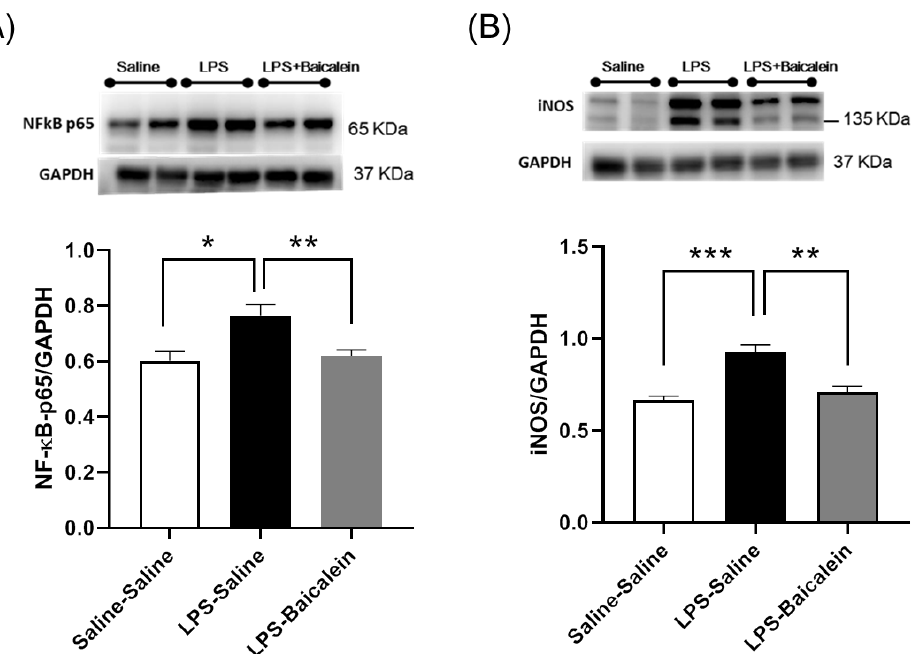
Figure 6. Effect of Baicalein on the protein levels of NF- κ B-p65 and iNOS in the hippocampi of mice. Levels of NF- κ B-p65 ( A ) and iNOS ( B ) in the hippocampus increased after administration of LPS (5 mg/kg, i.p.). Treatment with baicalein (3 mg/kg, i.p.) 1 h after LPS administration could significantly reduce the levels of both proteins. Data are presented as means ± SEM. ( n = 8) * p < 0.05, ** p < 0.01, *** p < 0.001.